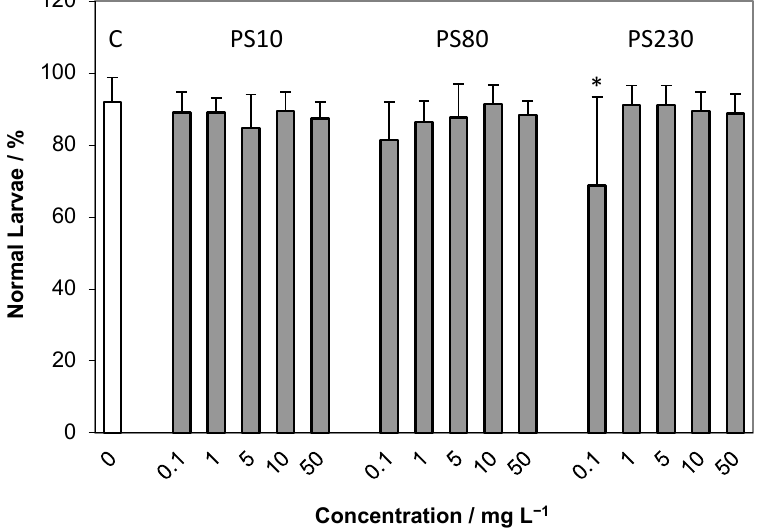
Figure 4. Percentage (mean ± SD) of normally developed plutei larvae after 72 h exposure to various concentrations of 10, 80 and 230 µ m PS microparticles (C—control). * p < 0.05.